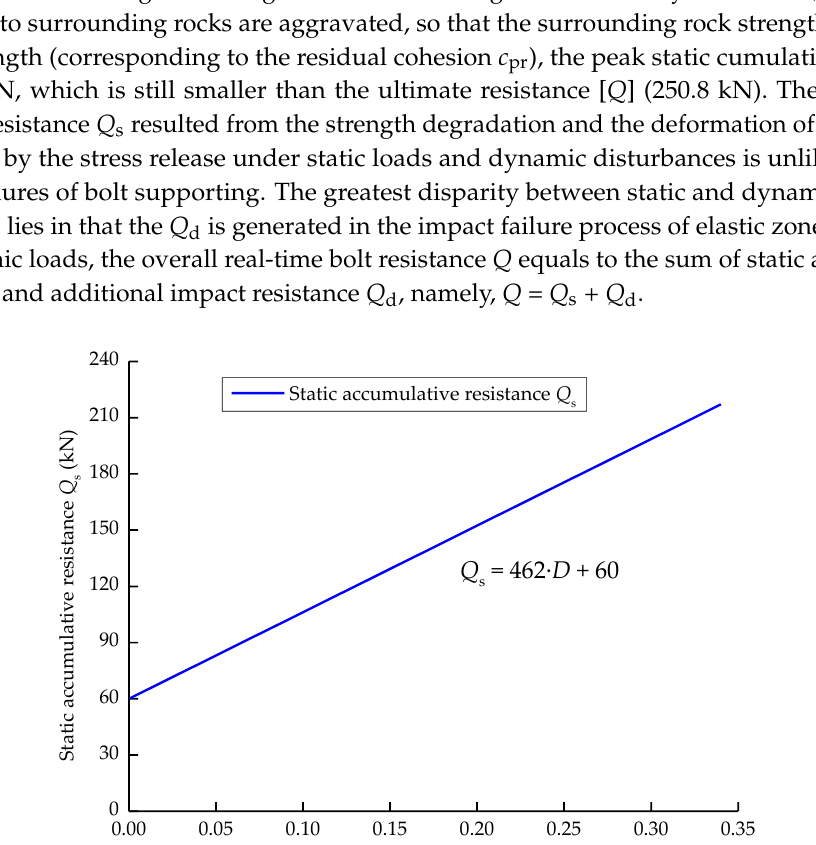
s and damage factor D of